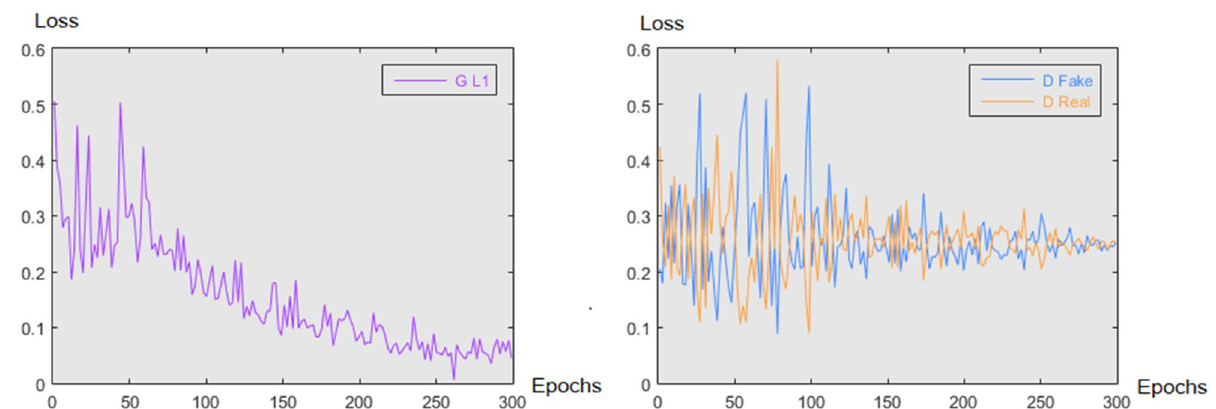
Figure 5. The L1 loss from the generator (left) is shown in purple and the D Fake and D real losses from the discriminator (right) are shown in blue and orange respectively for all epochs during training for the DoseGAN